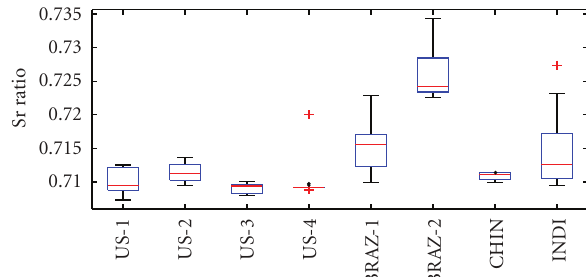
Figure 3: Boxplot showing the spread and deviation within each region for the SrIR